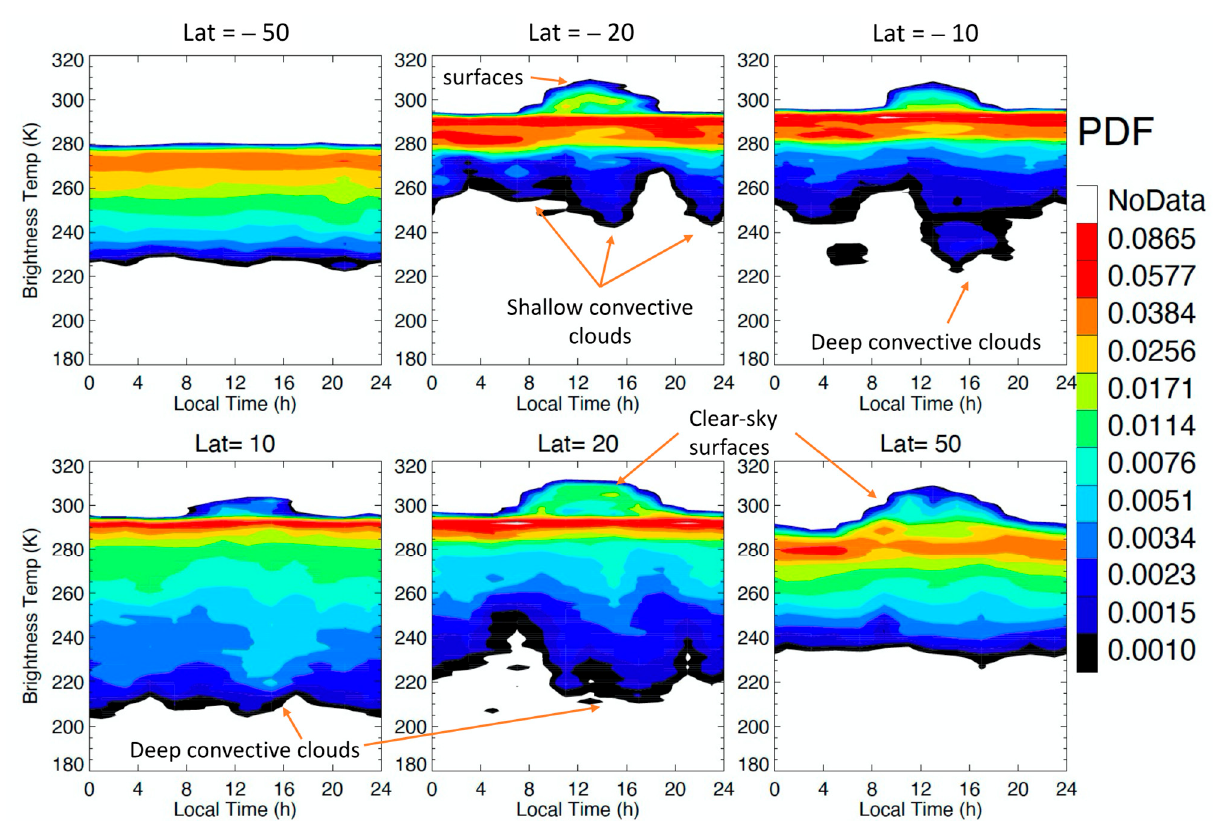
Figure 14. The local-time variation of CTI band2 temperature PDF at selected latitudes for June–August 2019. Normalized PDFs were generated for each 2-hourly local time bin and each 5 ° latitude bin.